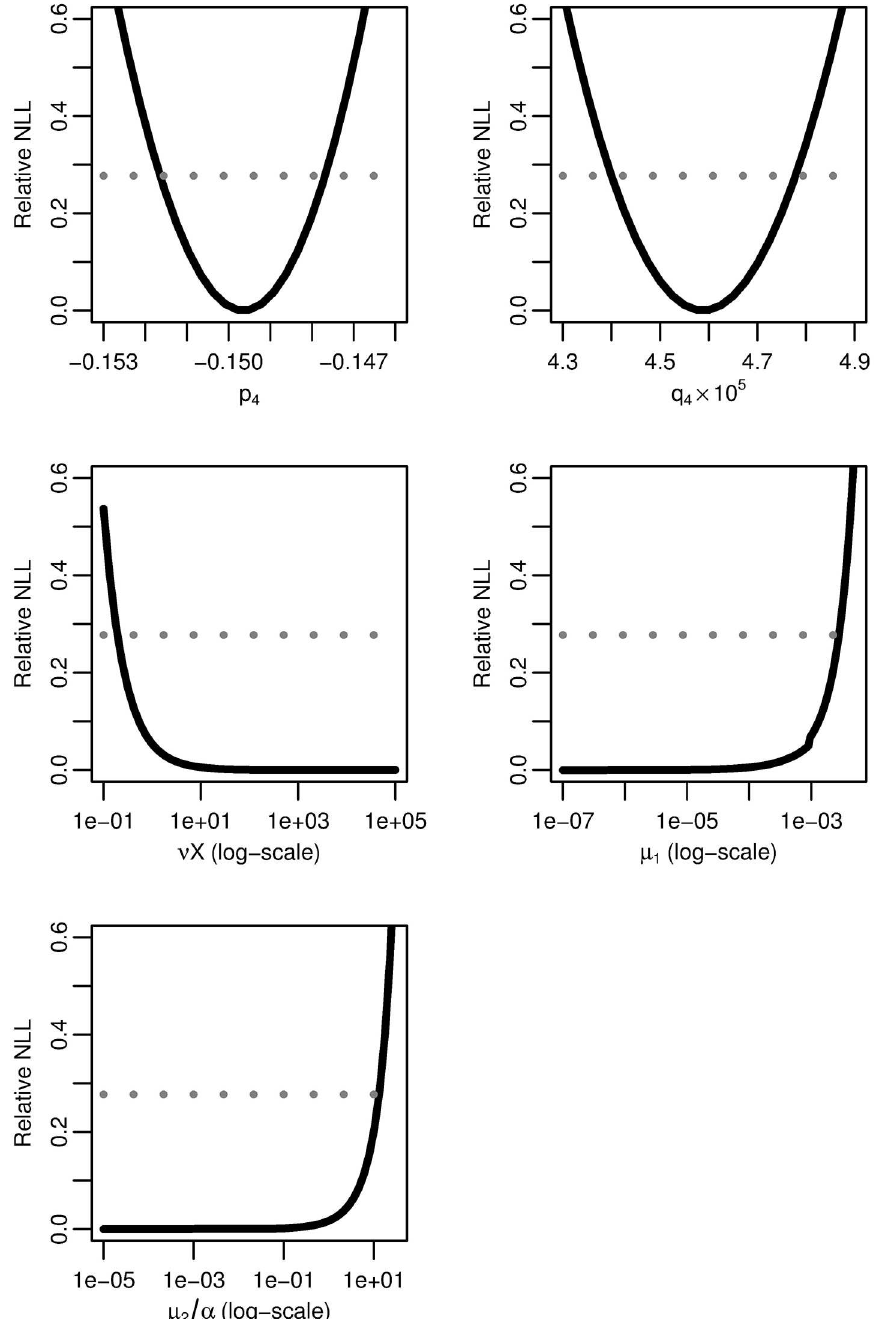
Fig 8. Four-stage model profile likelihoods. Profiles of the relative negativelog-likelihood (NLL) of the four- stage clonal expansionmodel as each of parameter combinations p 4 , q 4 , ν X , μ 1 , and μ 2 / α are varied whilethe remaining parameters are fit. The gray dotted line gives the α = 0.01 thresholdfor simultaneous confidence intervals based on the relative negativelog-likelihood. Parameter combinations p 4 and q 4 are identifiable, while ν X , μ 1 , and μ 2 / α are